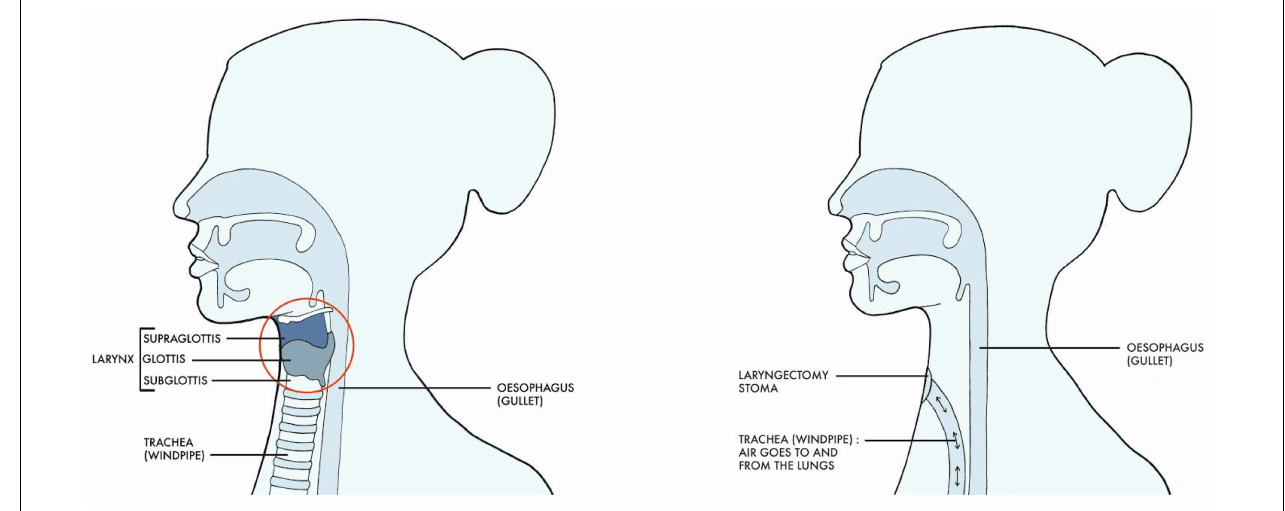
FIGURE 1 | Anatomical changes seen before and after laryngectomy (Drawing Claire Holmes).